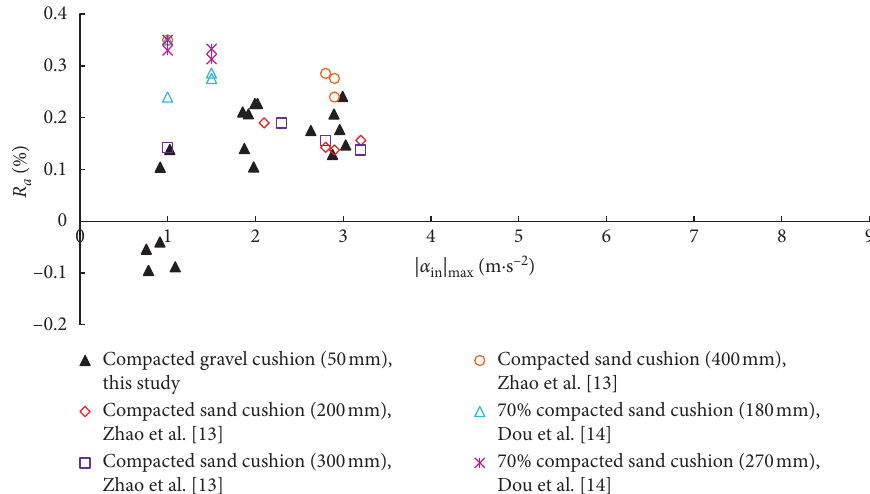
Figure 12: Comparison of the seismic isolation performance of the cushions used in this study and reported in the